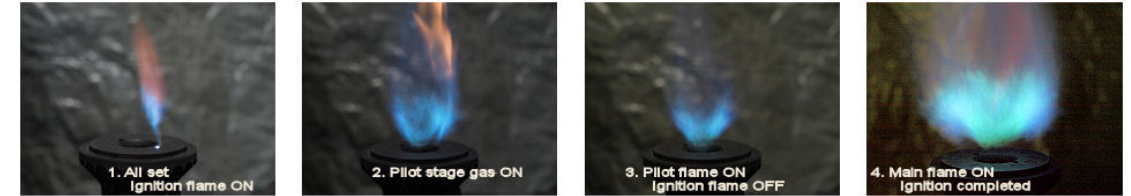
Figure 12. The smooth ignition sequence of the CBO4 burner.